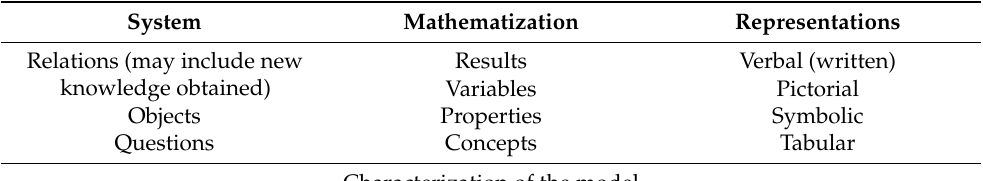
Table 2. Analysis template proposed for the investigation of school models (source: prepared by the authors). System